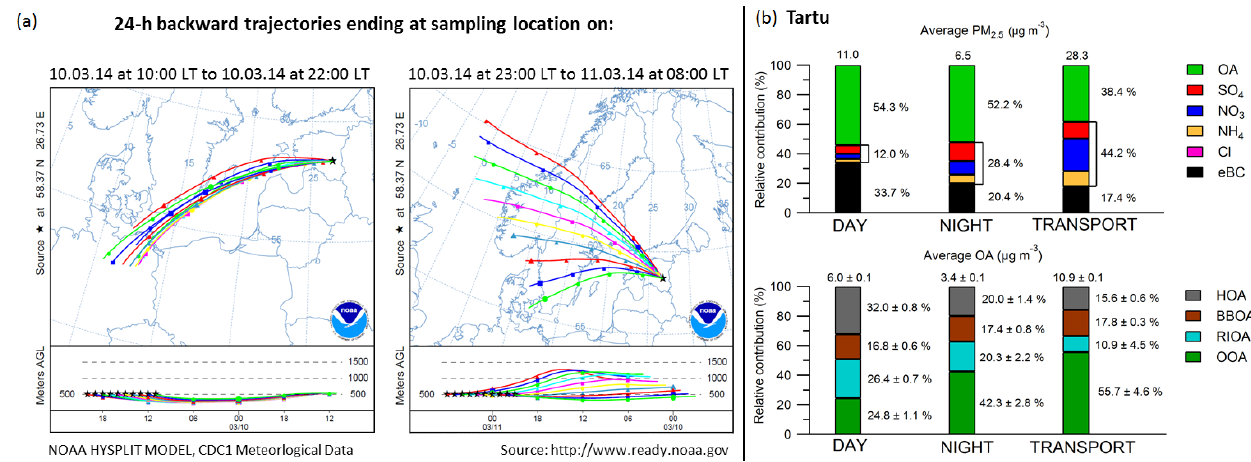
Figure 7. (a) 24h back trajectories (NOAA HYSPLIT MODEL) of the air masses ending at the sampling location (Tartu) during the transport event (10 March between 10:00 and 22:00LT, left panel) and the successive hours (from 10 March at 23:00LT until 11 March at 08:00LT, right panel). (b) PM 2 . 5 mass concentration and chemical composition (top panel) and OA mass concentration and relative contributions of the OA sources (bottom panel) during the measurements in Tartu during daytime, nighttime, and transport event. Errors indicate the standard deviation among 100 bootstrap